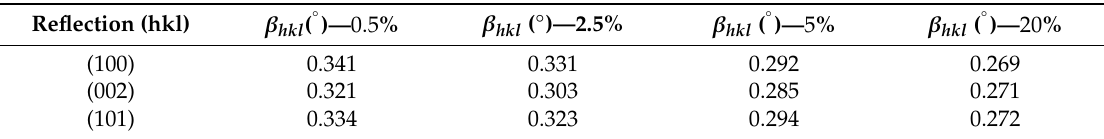
Table 3. The FWHM of the di ff raction peaks on (100), (002) and (101) at 0.5%, 2.5%, 5% and 20% concentration of ZnO nanoparticles.